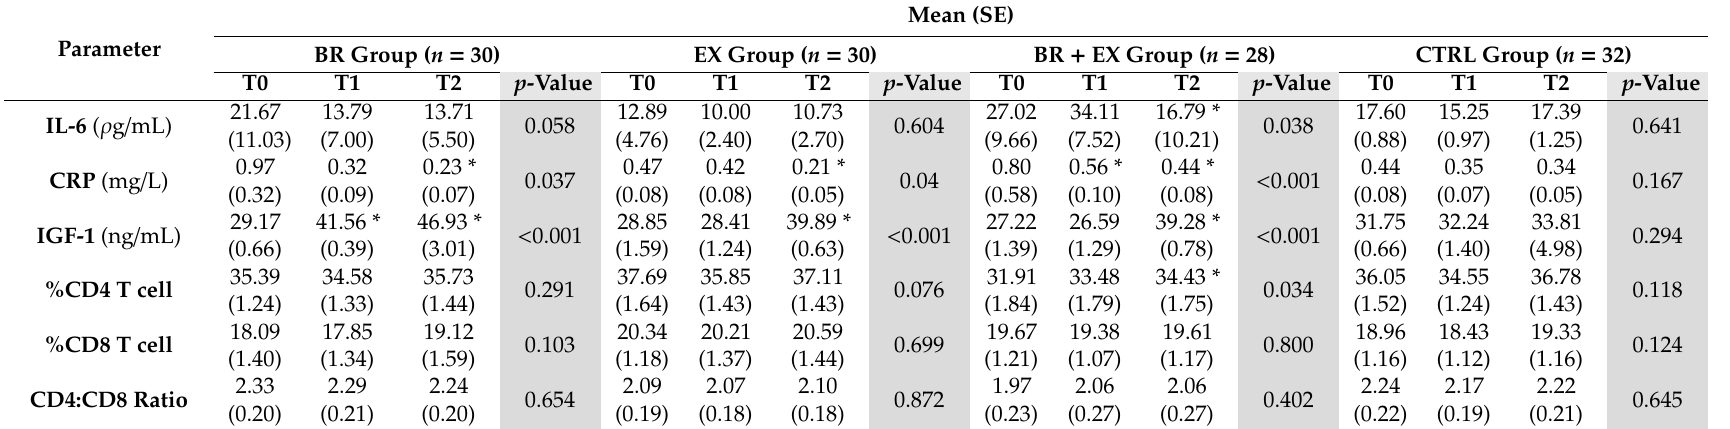
Table 5. Changes in aging and immunosenescence biomarkers in all 4 di ff erent intervention groups during the 24-week intervention period. (T0 = baseline, T1 = 12 weeks, T2 = 24